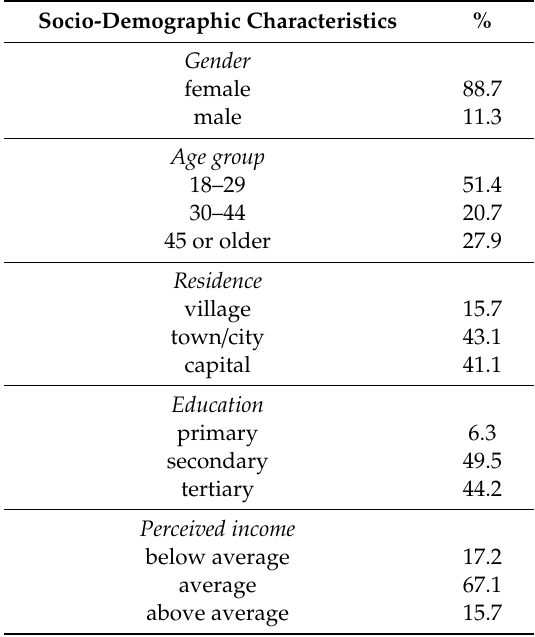
Table 1. Socio-demographic characteristics of the sample.